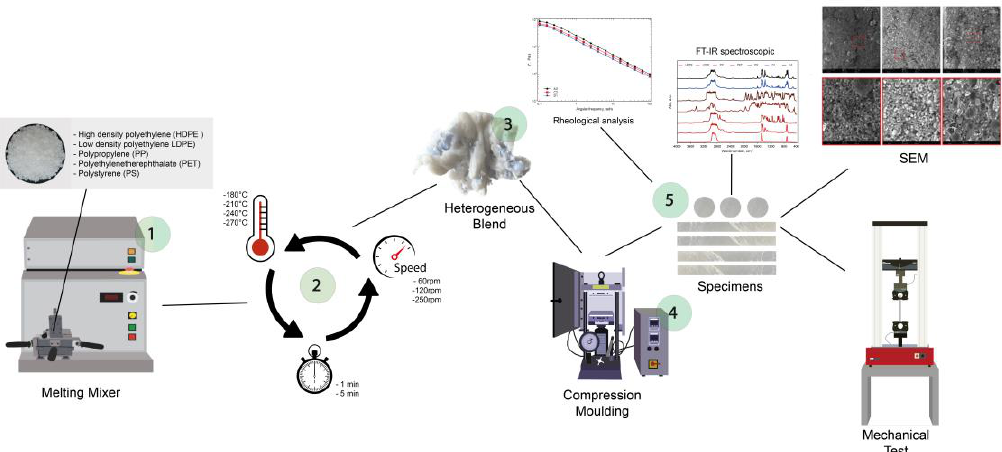
Figure 1. Diagram illustrating the steps in the preparation and characterization of the heterogeneous mixtures .